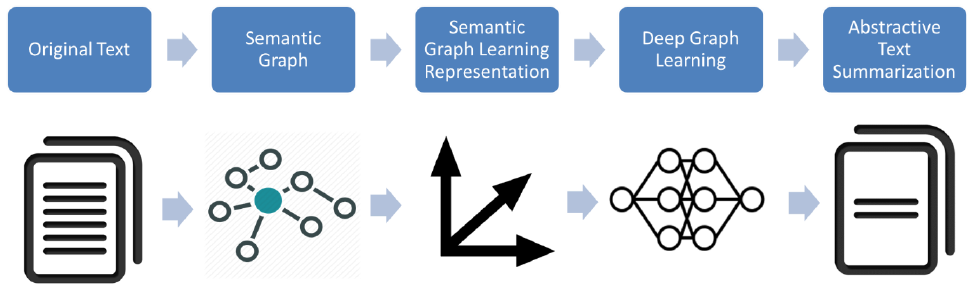
Figure 1. Proposed